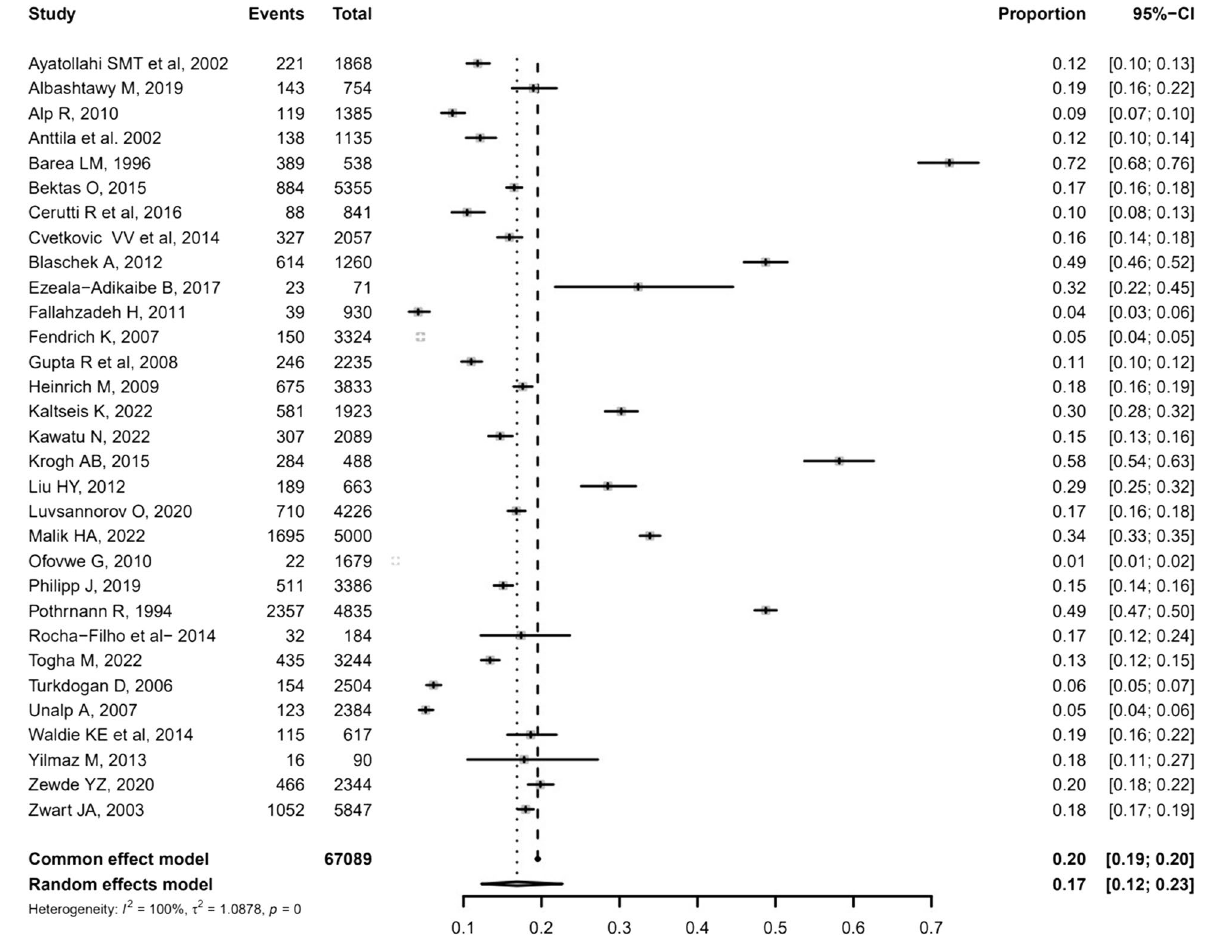
Fig. 4 Forest plot of the overall weighted prevalence data of tension type headache. Total: total population sample; Events: number of primary headache diagnosis; CI: Confidence